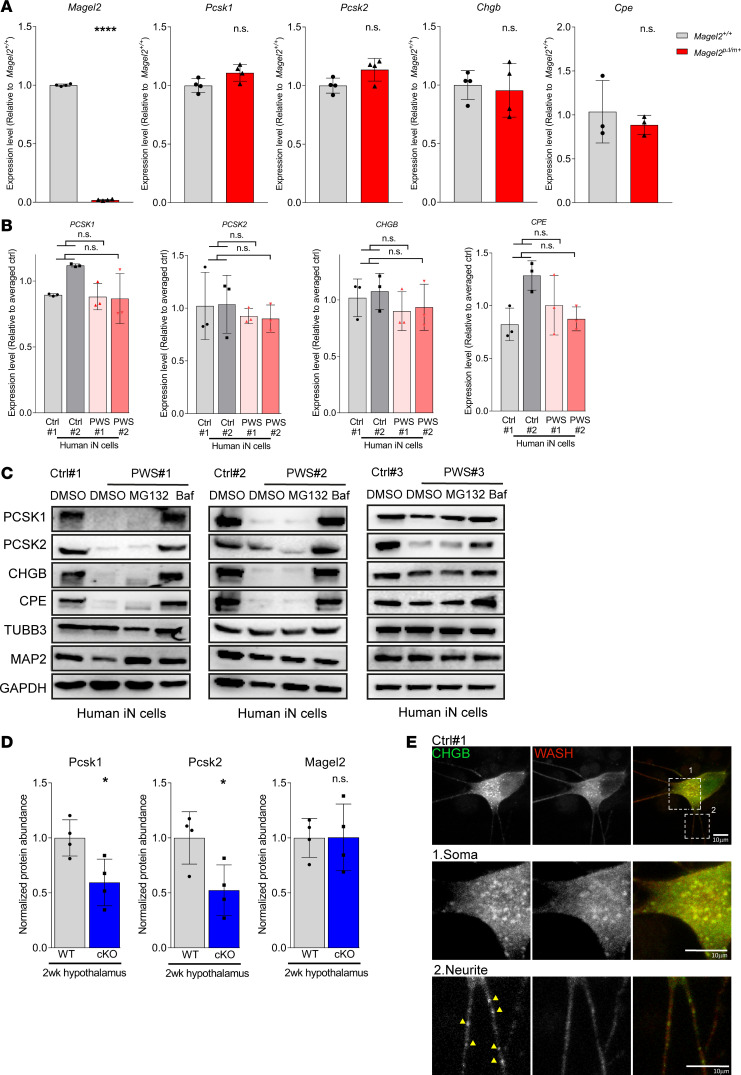
WASH-mediated protein trafficking prevents lysosomal degradation of SG proteins.(A) Transcript levels of Pcsk1, Pcsk2, Chgb, and Cpe in 8-week-old Magel2pΔ/m+ and Magel2+/+ mouse hypothalamuses, n > 3 per genotype. Each data point represents 1 animal, plotted as mean ± SD and analyzed by unpaired, 2-tailed t test, ****P < 0.0001. (B) Transcript levels of PCSK1, PCSK2, CHGB, and CPE between control and PWS iN at 14 days postinduction. Each data point represents 1 induction experiment (n = 3), plotted as mean ± SD and analyzed by 1-way ANOVA. (C) Western blot analysis shows rescued expression of PCSK1, PCSK2, CHGB, and CPE in PWS iN at 14 days postinduction following inhibition of lysosomes by Baf (1 μM, 7 hours) but not inhibition of proteasomes by MG132 (10 μM, 7 hours). DMSO served as vehicle control. GAPDH served as loading control. (D) Quantification of Western blot analysis confirmed reduced expression of Pcsk1 and Pcsk2 in 2-week-old Washc1 conditional knockout (cKO) mouse hypothalamuses, n = 4 per genotype. Gapdh served as loading control. Each data point represents 1 animal, plotted as mean ± SD and analyzed by unpaired, 2-tailed t test, *P < 0.05. (E) Representative images of immunofluorescence staining with CHGB and WASH at both soma and neurite in control iN. Scale bars indicate 10 μm.